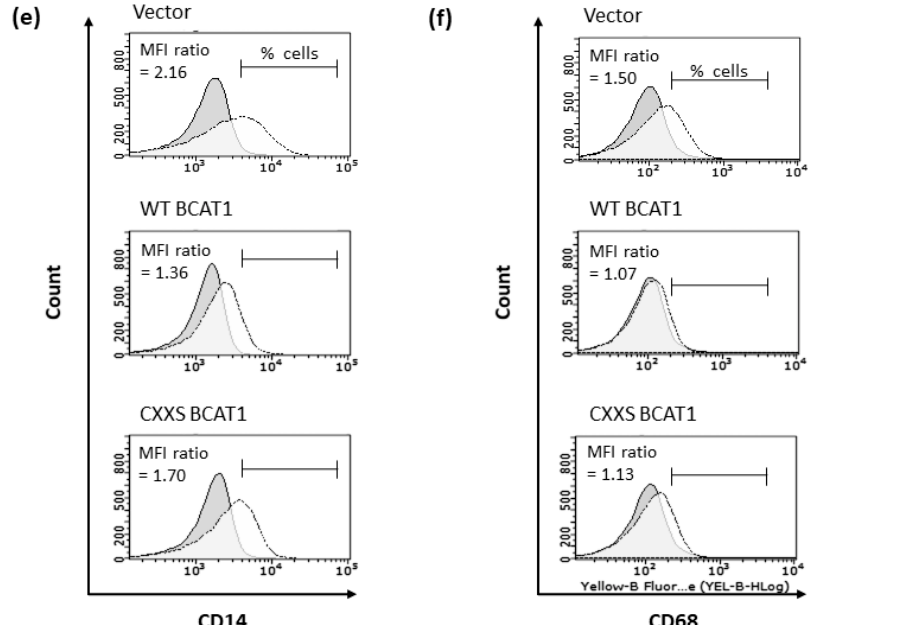
Figure 7. Differential myeloid cell marker expression (CD14 and CD68) and intracellular ROS following treatment with PMA. U937 monocyte to macrophage differentiation was induced by incubation with ±10 ng/mL PMA for 48 h, to control for BCAT1 metabolic and CXXC motif antioxidant, activity cells were supplemented with 20 mM Gabapentin and 10 mM N-acetyl cysteine (NAC) respectively. ( a ) Chart displaying DCFDA MFI ± PMA for WT BCAT1, CXXS BCAT1, and Vector control U937 cells. ( b ) Light microscope Vector U937 cells illustrate a macrophage-like morphology following PMA treatment. Charts displaying percentage; ( c ) CD14 positive cells, ( d ) CD68 positive cells with ( e ) representative flow cytometric histograms for CD14 expression and ( f ) CD68 expression. Data presented are mean ± SD. Significant differences were calculated using 2-way ANOVA with Bonferroni post-test where, * p < 0.05, ** p < 0.01 and *** p < 0.001 ( n = 3). See Supplemental Figure S5 for flow cytometric gating strategy.